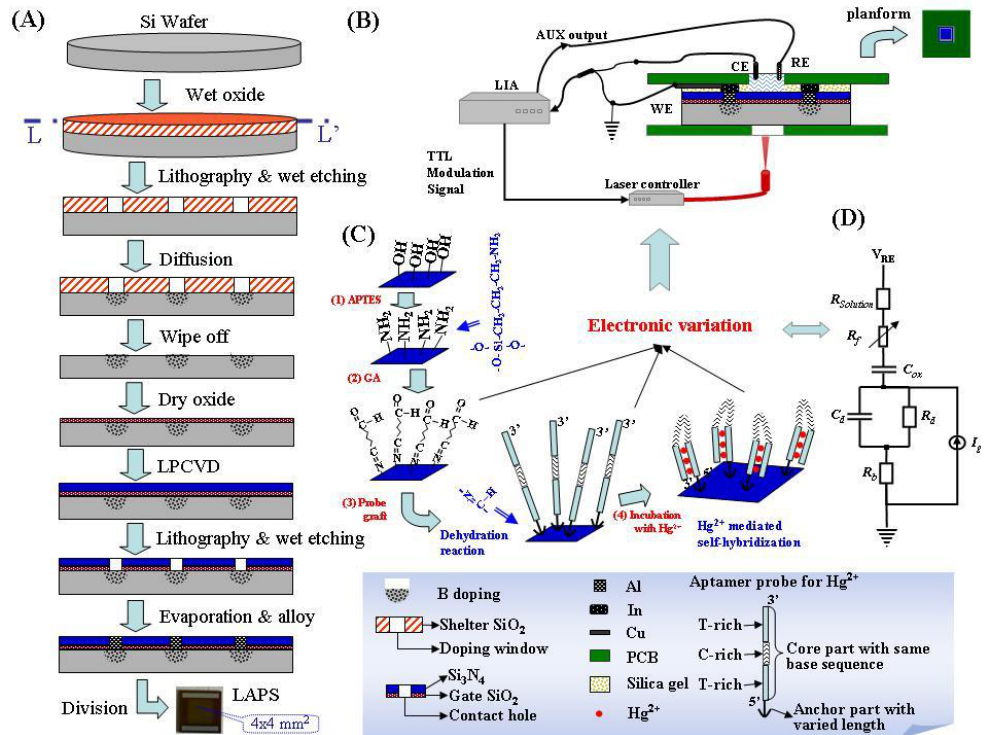
Figure 1. Illustration of an aptamer LAPS system ( A ) fabricating process of LAPS; ( B ) the encapsulated LAPS chips and the detection system; ( C ) the protocol for ssDNA probe immobilization and mercuric ion formed self-hybridization on LAPS; and ( D ) the equivalent circuit for aptamer LAPS.